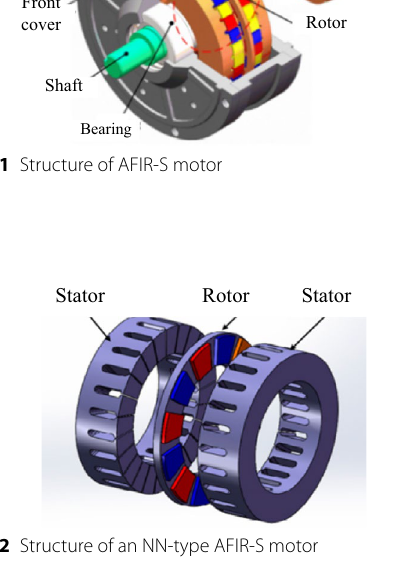
Figure 12 Structure of an NN-type AFIR-S motor